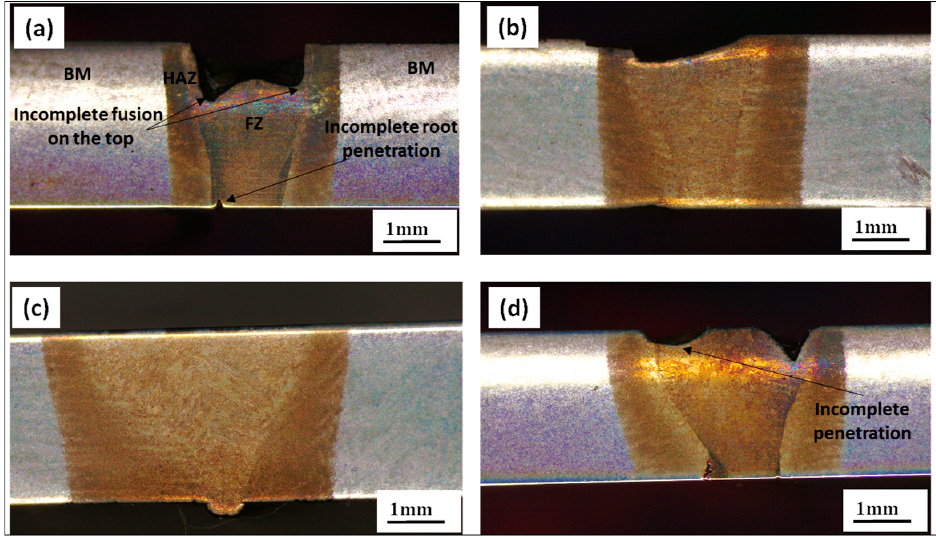
Figure 4. The cross-sectional appearance of weld bead under different weld conditions ( a